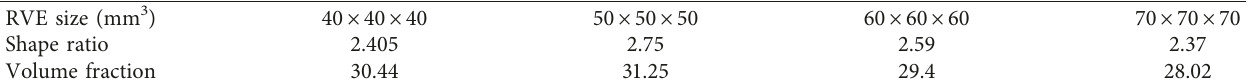
Table 6: Volume fraction and shape ratio for the four sizes of RVE.